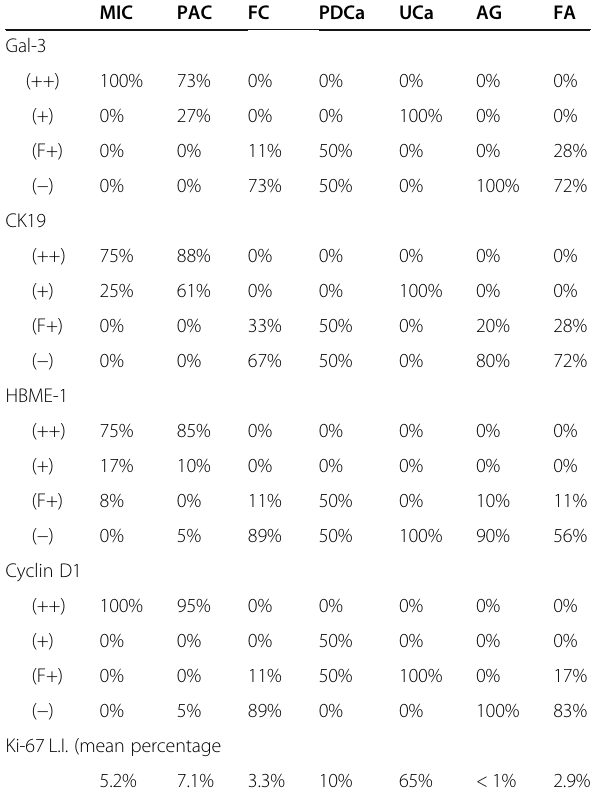
Table 3 Immunohistochemical results for other markers